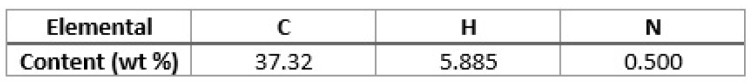
CHN elemental analysis of synthesized CDs